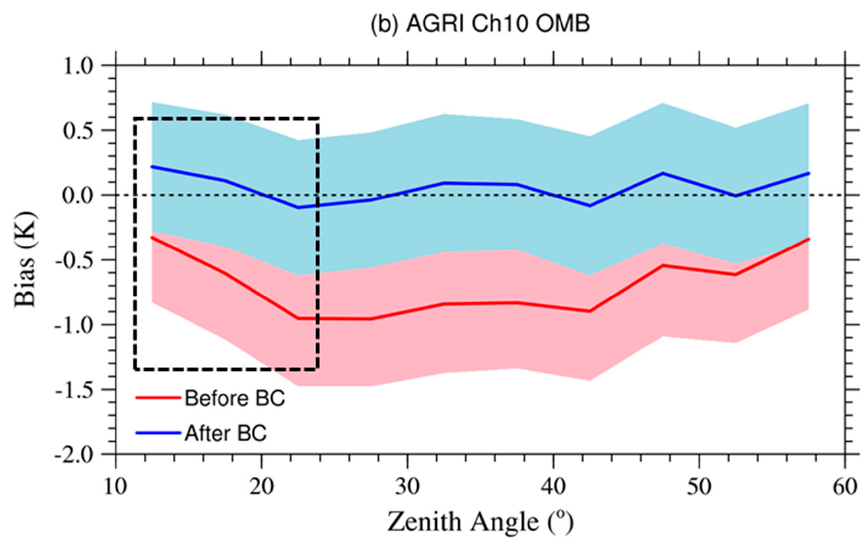
Figure 6. Zenith-angle dependent of the assimilated O − B biases (unit: K) before (red curves) and after (blue curves) bias corrections (BCs) of the FY-4A AGRI ( a ) channel 9 and ( b ) channel 10, from 0000 UTC to 2400 UTC (interval: 3 h) on 5 July 2020. One-standard deviations are indicated by the shaded colors.